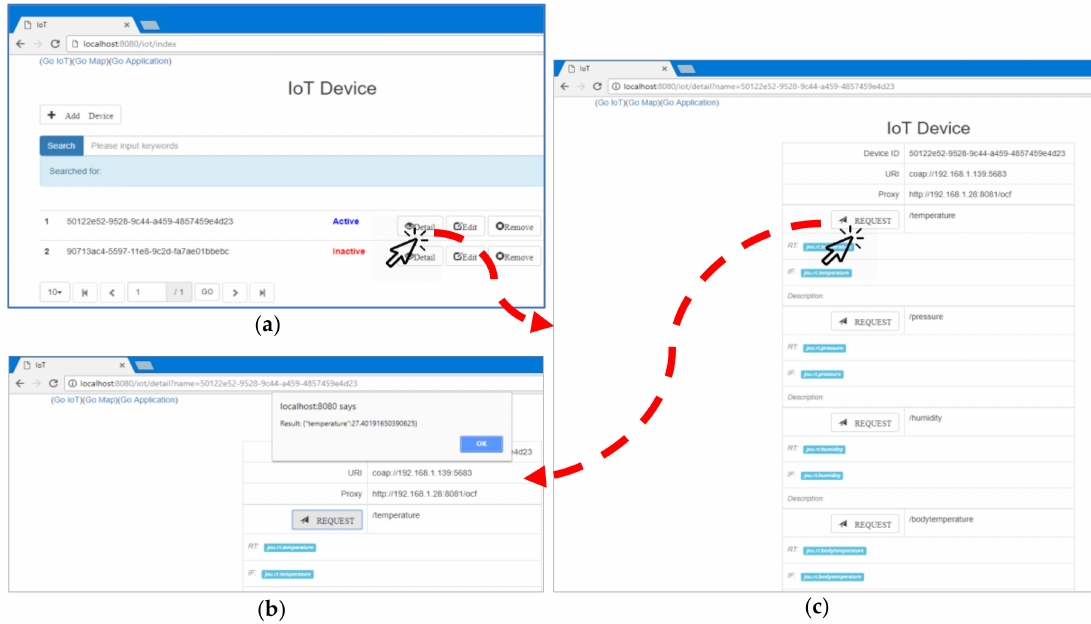
Figure 14. IoT resource discovery and accessing results on web client. ( a ) IoT device discovery. ( b ) IoT resource discovery. ( c ) IoT resource